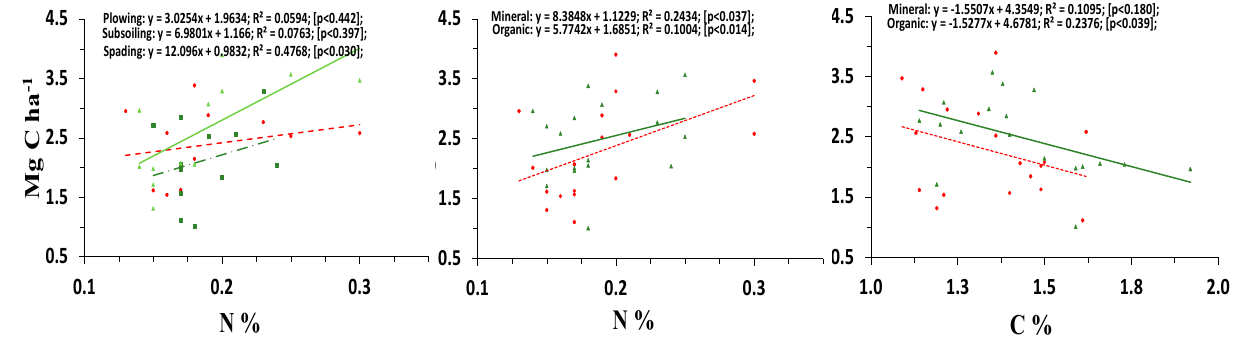
Figure 6. Soil CO 2 flux plotted in the two fertilization (Mineral - - - and Organic — ) and three soil tillage (Plowing - - - , Subsoiling — , and Spading - - - ) against total carbon (C%) and total nitrogen (N%) during wheat crop seasons.